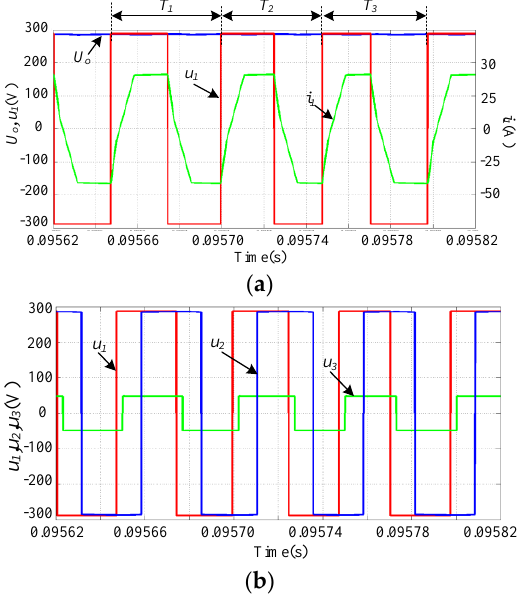
Figure 16. Simulated waveforms of shifted-phase angle control with continuously chaotic modulation: ( a ) converter voltage, current of port 1 and output voltage of port 2; ( b ) converter voltages of port 1, 2 and 3.